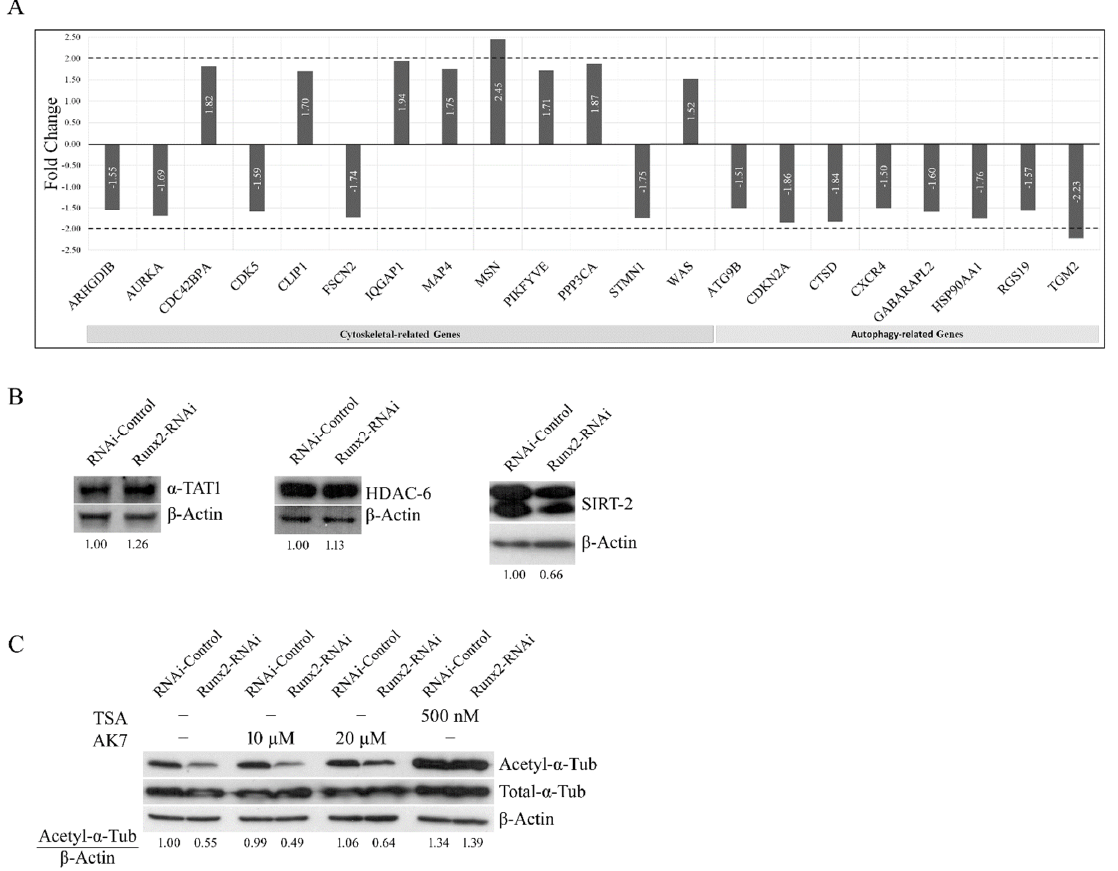
Figure 4. Core autophagy-related genes and cytoskeleton regulatory genes are unchanged with Runx2 silencing in bone-derived MDA-MB-231 cells. ( A ) qRT-PCR array analysis of autophagy and cytoskeletal-related genes in BoM-MDA-231 control and Runx2-RNAi cells. mRNA was reverse transcribed and profiled for these genes using PCR array #PAHS-088Z (84 cytoskeletal-related genes) and #PAHS-084Z (84 autophagy-related genes), results for both arrays were normalized to 5 housekeeping genes. ( B ) Western blot analysis shows the protein levels of the positive (alpha-tubu- lin acetyltransferase-1 (ATAT1)) and negative (HDAC6 and sirtuin2 (SIRT2)) regulators of α-tubulin acetylation in BoM-MDA-231 control and Runx2-RNAi cells. ( C ) α-tubulin acetylation levels in BoM-MDA-231 control and Runx2-RNAi cells treated with the pan histone deacetylase (HDAC) inhibitor trichostatin A (TSA) and the SIRT2 specific inhibitor AK7 for 24 h with indicated doses. Next, we examined the protein levels of the positive regulator alpha-tubulin-acetyl- transferase-1 (ATAT-1) and the negative regulators of α-tubulin acetylation HDAC6 and sirtuin2 (SIRT2) [25]. The whole-cell lysates from BoM-MDA-231 cells revealed no signif- icant changes in HDAC6 and ATAT1 levels with Runx2 knockdown, while SIRT2 protein showed a mild reduction in response to Runx2 knockdown (Figure 4b). Treatment with the sirtuin2 specific inhibitor AK7 marginally increased the tubulin acetylation levels, while the pan HDAC inhibitor TSA produced a robust increase (Figure 4c), suggesting that HDAC6 is the primary deacetylase of a-tubulin in BoM-MDA-231 cells [3]. Altogether the qRT-PCR array analysis of the regulators of the cytoskeleton and autophagy pathways in BoM-MDA-231 showed that the core regulators of autophagy and cytoskeletal dynam- ics were unchanged with Runx2 silencing. Taken together with the protein levels of the regulators of α-tubulin acetylation, these results suggested a possibility of protein-protein